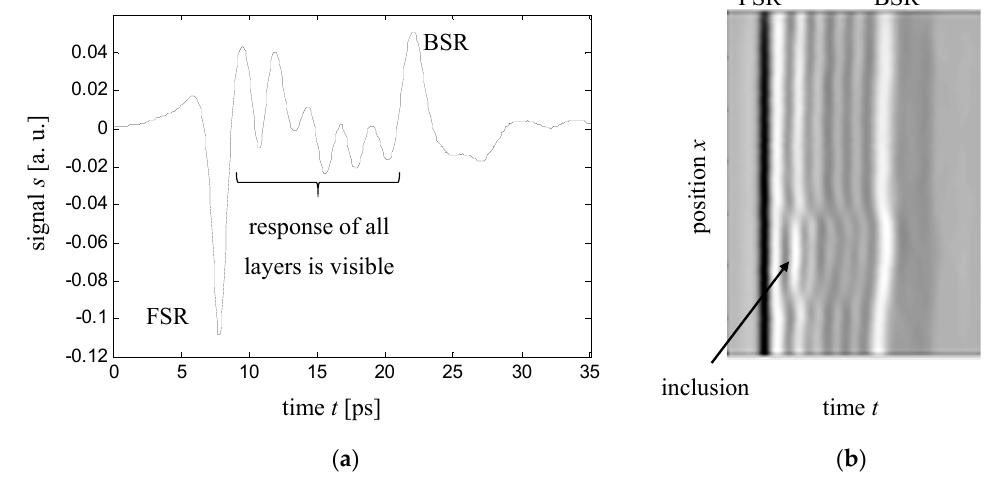
Figure 5. Signals acquired in case of inspection of layered composite material (basalt fiber-reinforced) consisting of six layers: ( a ) A-scan; and ( b ) B-scan; FSR-front surface reflection, BSR—back surface reflection.